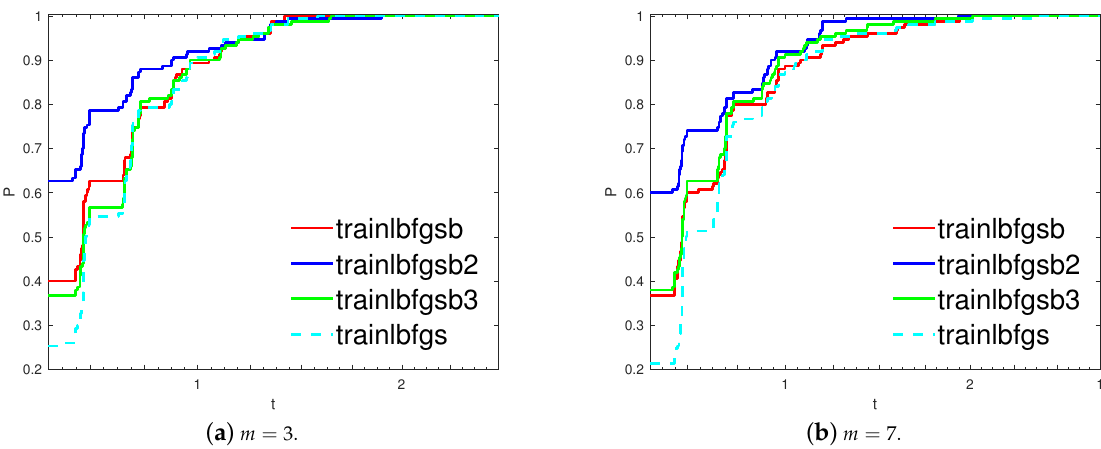
Figure 6. Log 10 scaled performance profiles based on F 1 -score for the diabetes classification